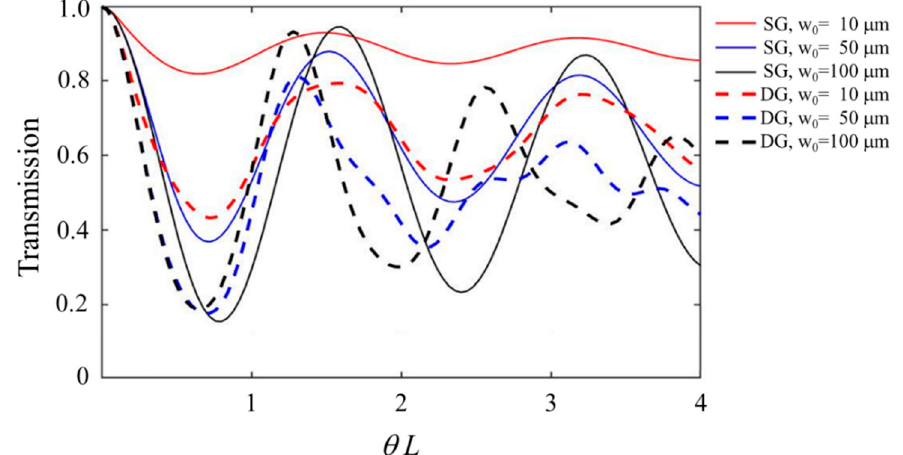
Figure 2. The simulated transmission curves of the single-grating (SG) and the dual-grating (DG) EOPBD for different beam sizes are plotted as a function of θ L in solid lines and dashed lines, respectively. Different beam radii are presented in red: 10 µ m, blue: 50 µ m and black: 100 µ m.